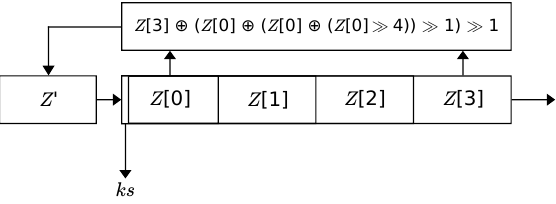
Figure 6: Authentication challenge algorithm